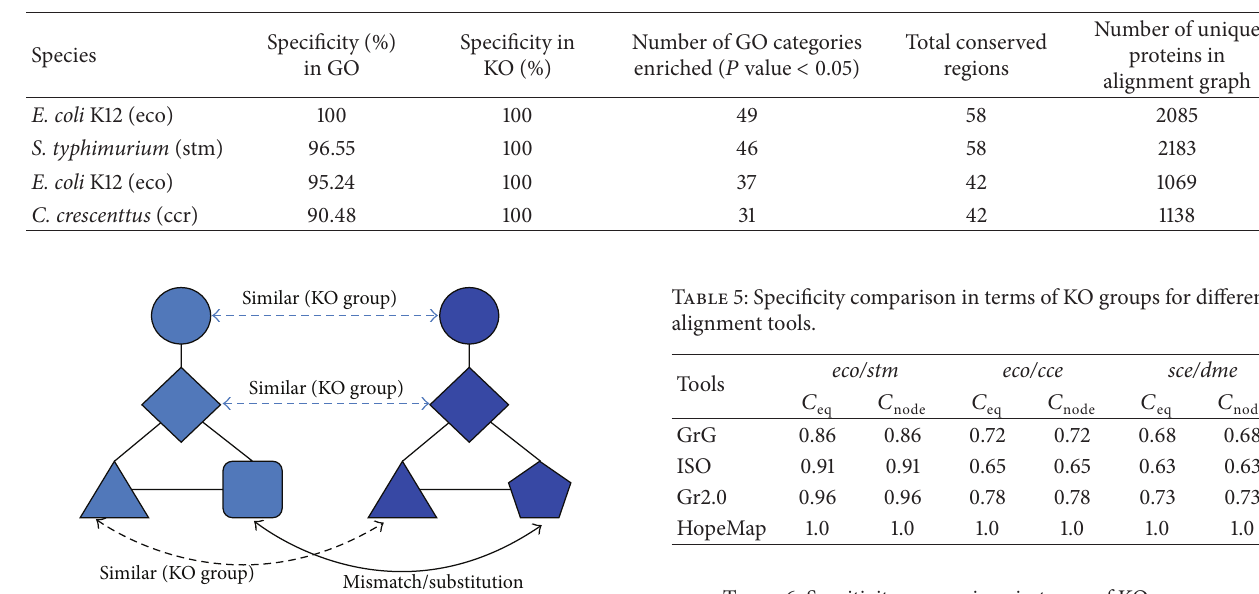
Table 4: Specificity and sensitivity results for eco/stm and eco/ccr from HopeMap.